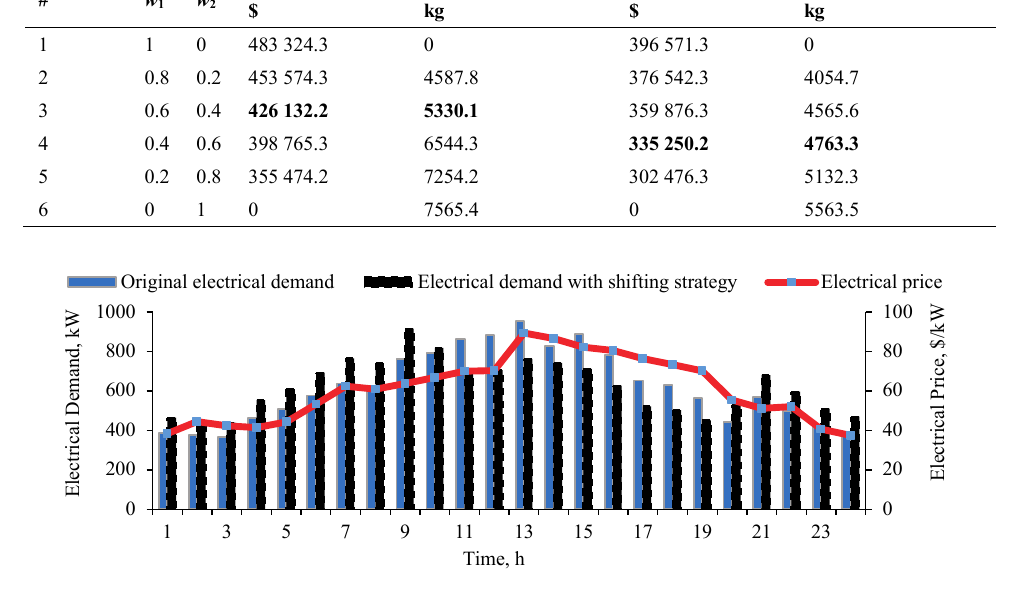
Fig. 4. Electrical demand with demand shifting